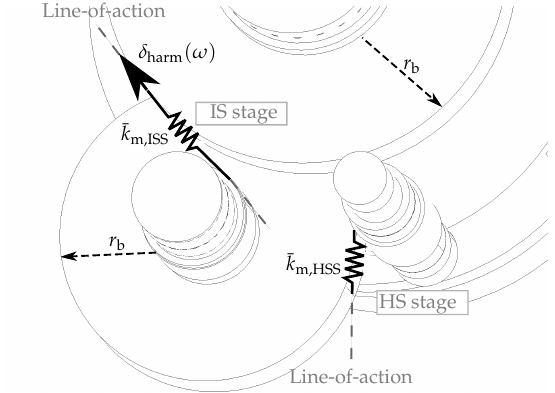
Figure 13. Approximation of internal components and gear contact, excited by harmonically varying transmission error δ harm ( ω )